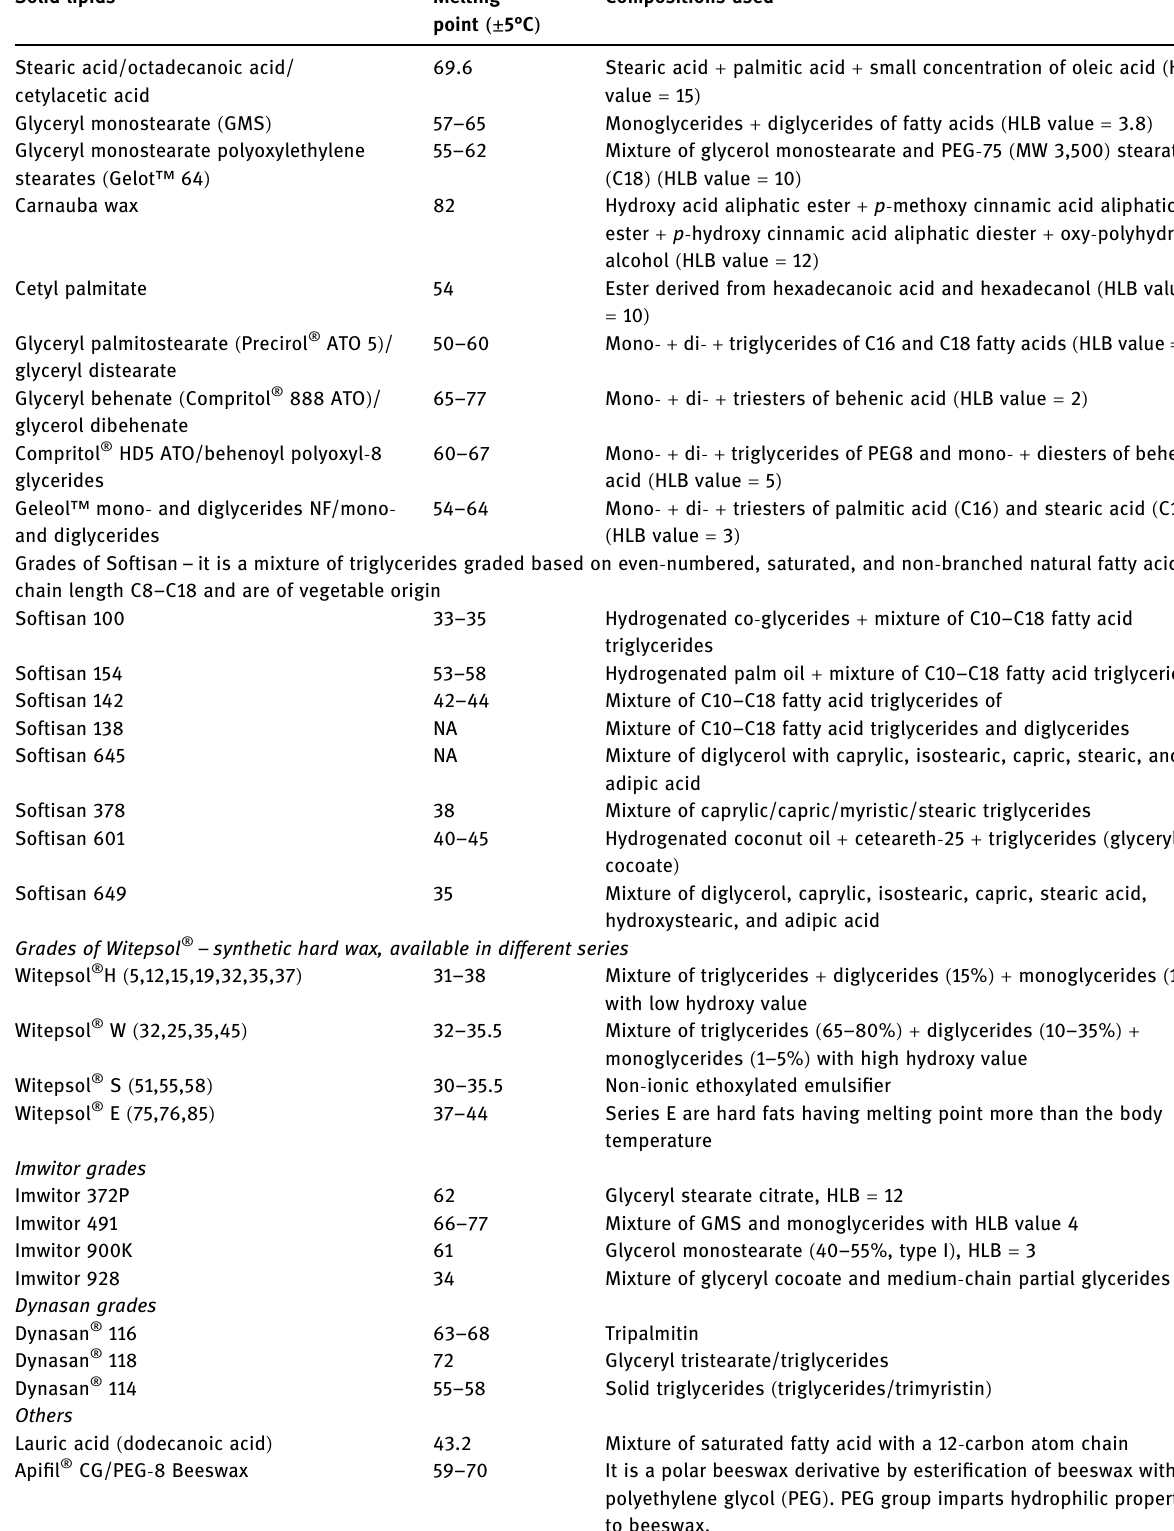
Table 1: List of solid lipids, their melting points, and compositions used in the NLC formulations Solid